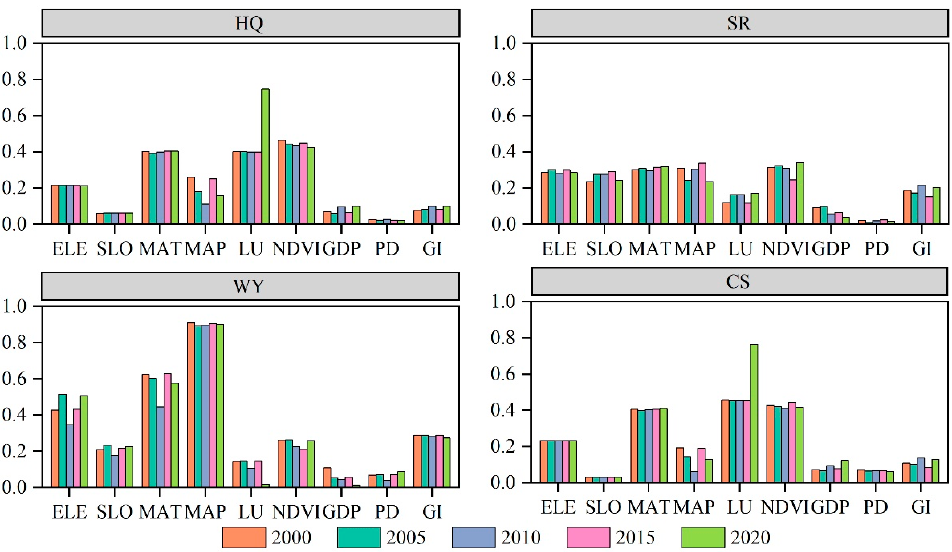
Figure 8. The q-value ( p < 0.01) of ESs in the Tianshan Mountains.